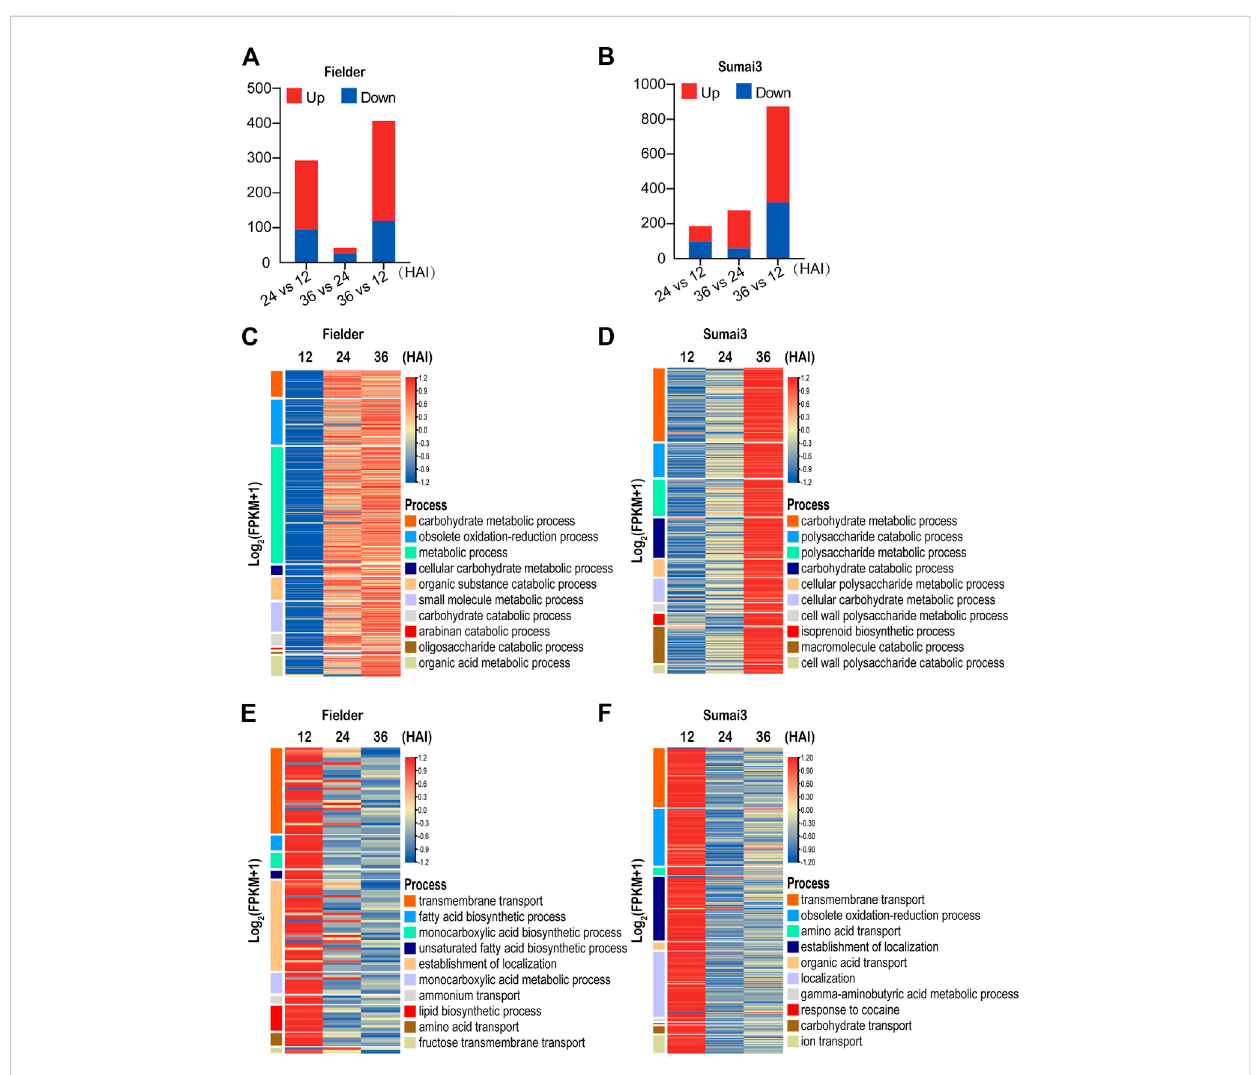
FIGURE 3 Temporal expression patterns and GO analysis of differentially expressed Fusarium graminearum genes in Fielder and Sumai3 (A) and (B) The numbers of signi fi cant DEGs in Fielder and Sumai3 within 36 HAI. Genes with log 2 (foldchange) ≥ 1 and p adj < 0.05 were identi fi ed as upregulated, while those with log 2 (foldchange) ≤ − 1 and p adj < 0.05 were identi fi ed as downregulated. (C) and (D) Heatmaps of signi fi cantly enriched GO categories associated with Fusarium graminearum genes upregulated in Fielder and Sumai3. (E) and (F) Heatmaps of signi fi cantly enriched GO categories associated with Fusarium graminearum genes downregulated in Fielder and